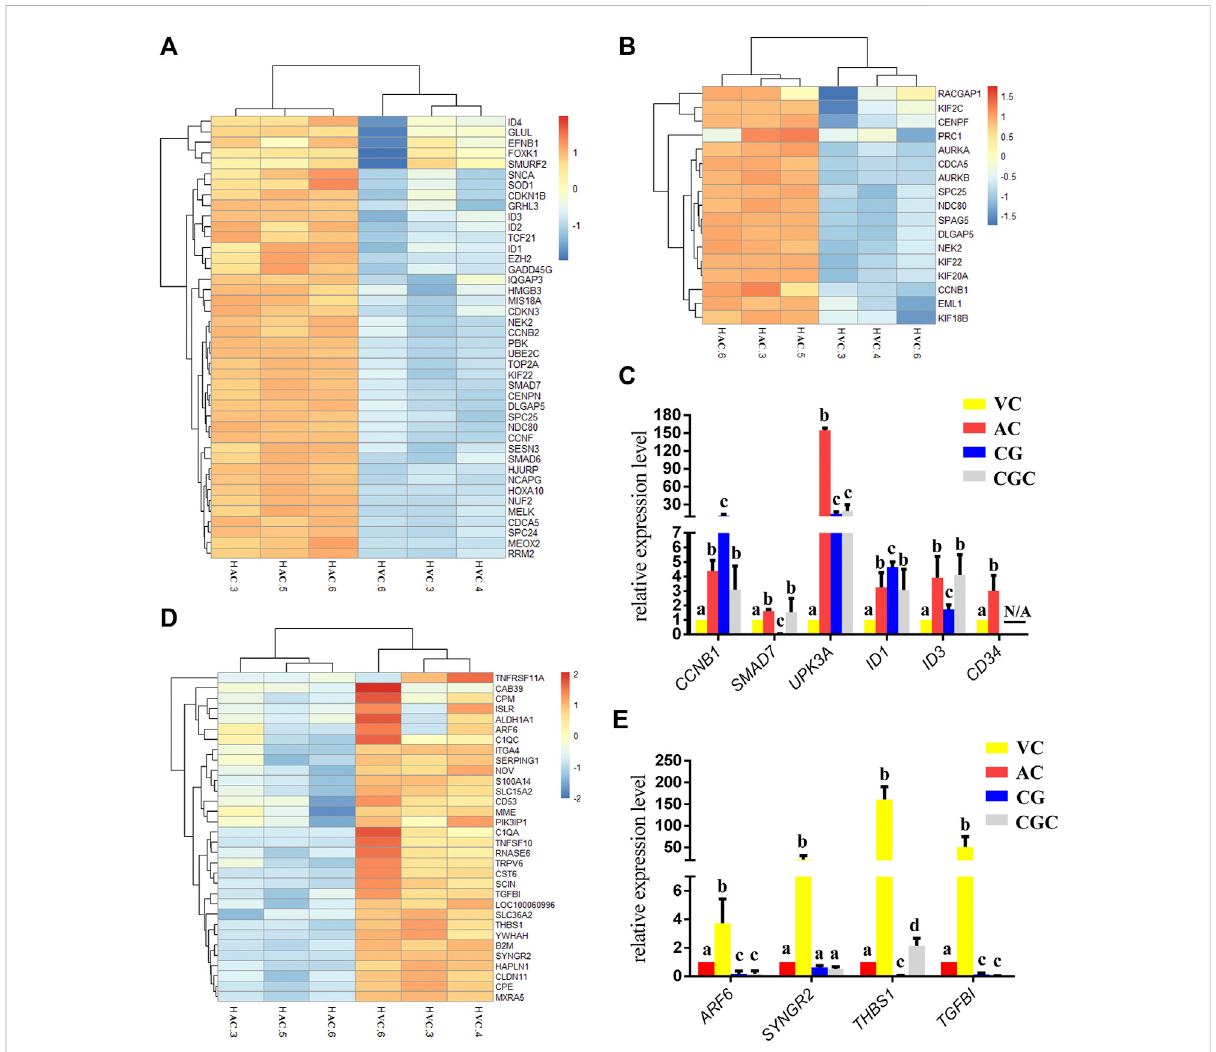
Heatmap of DEGs and histogram for qPCR results. (A, B) , Heatmap of DEGs up-regulated in allantochorion (AC): genes related to nuclear and chromosome activation in A, and genes related to spindle activation in B. (C) qPCR validation of DEGs up-regulated in AC. (D) Heat map representation of DEGs up-regulated in vitelline-chorion (VC). (E) qPCR validation of DEGs up-regulated in VC. Different letters in the histogram indicateasigni fi cantdifference( p -value < 0.05).CG,Chorionicgirdle;CGC,Binuclearchoriongirdlecellsthatformedafterthe invitro cultureof the chorion